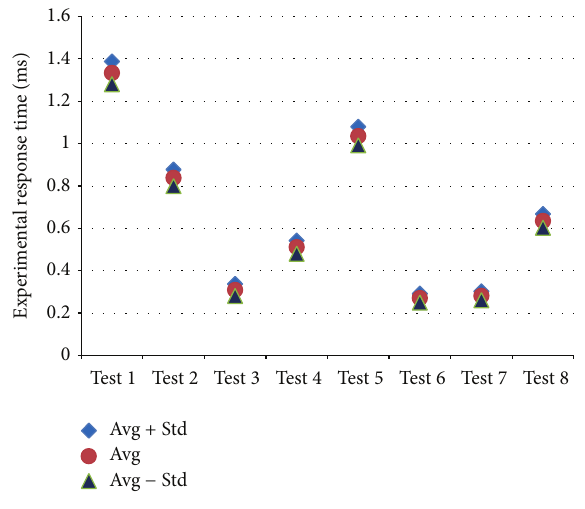
Figure 11: JAUS experiment test results. Table 2: Experiment results (the time is in the units of